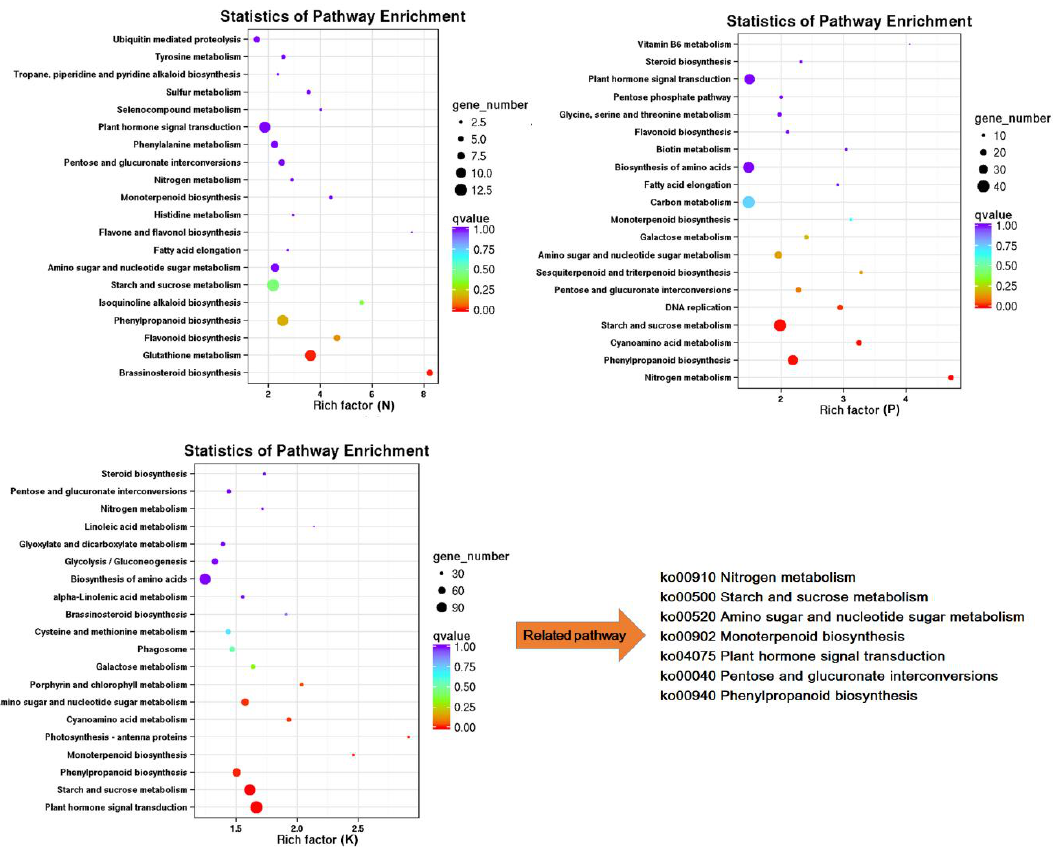
Figure 4. Kyoto Encyclopedia of Genes and Genomes (KEGG) pathway enrichment of differential expressed genes under N, P, and K starvation stress. The top 20 significantly enriched KEGG terms were selected. Each circle represents a KEGG pathway, the x -axis represents the enrichment factor, and the y -axis the name of KEGG pathway. The color of the circle refers to the q -value, and the size of the circle represents the number of genes mapped to the pathway.